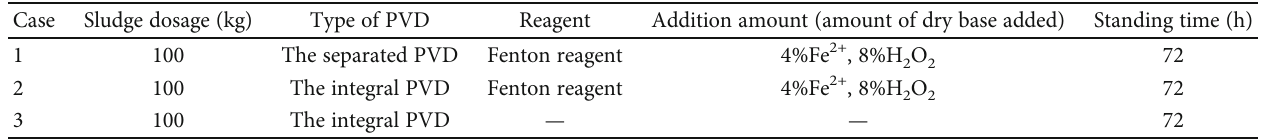
Table 4: Vacuum preloading